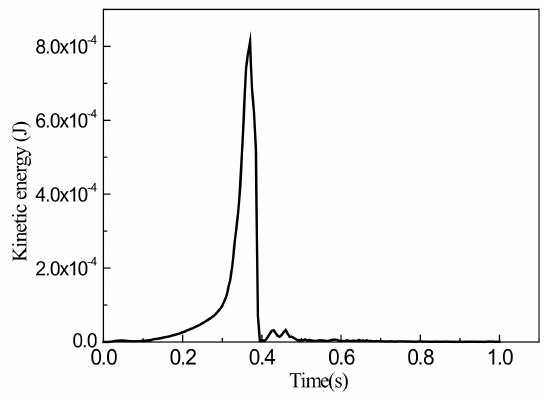
Figure 11. Variation of kinetic energy with time.